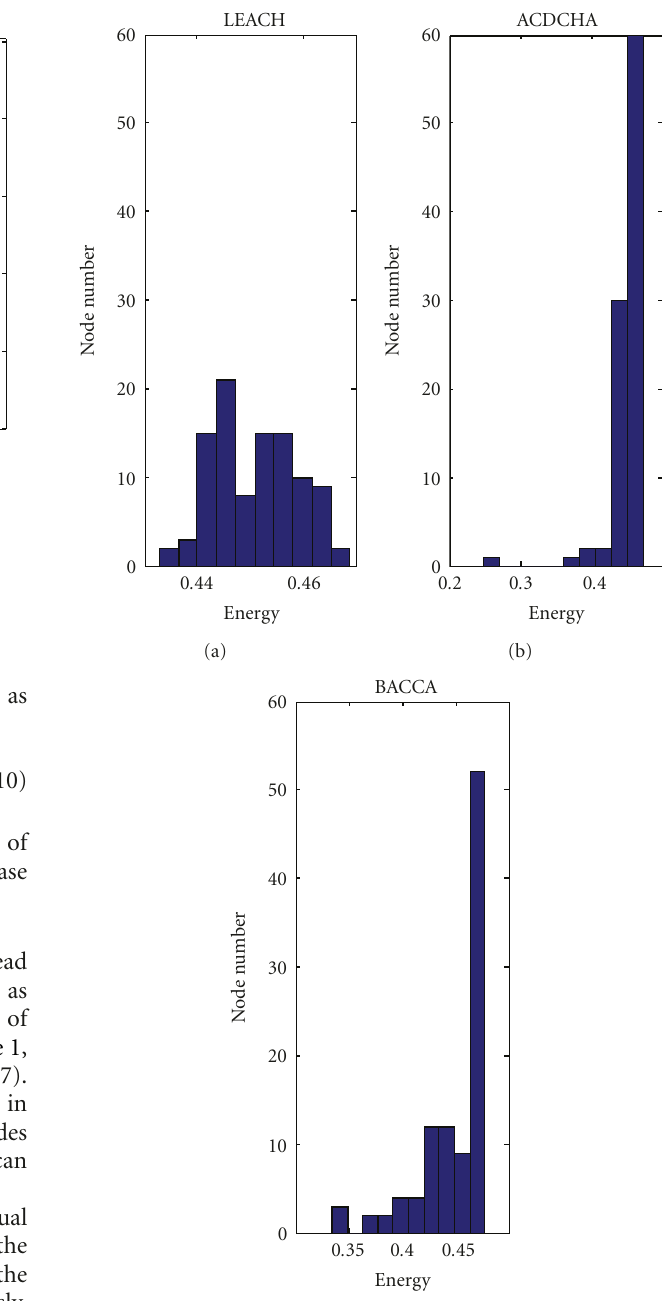
Figure 2: The energy of radar